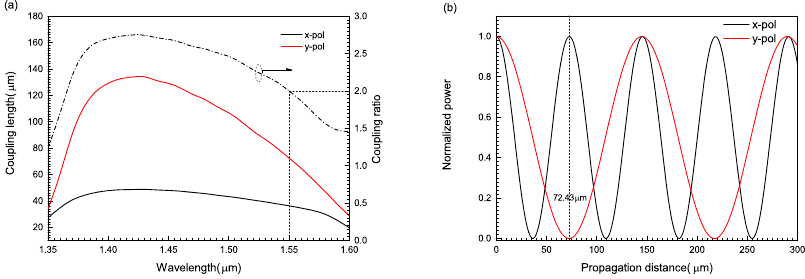
Figure 5. Variation of coupling length and coupling rate with wavelength ( a ), and variation of the normalized power with propagation distance ( b ).